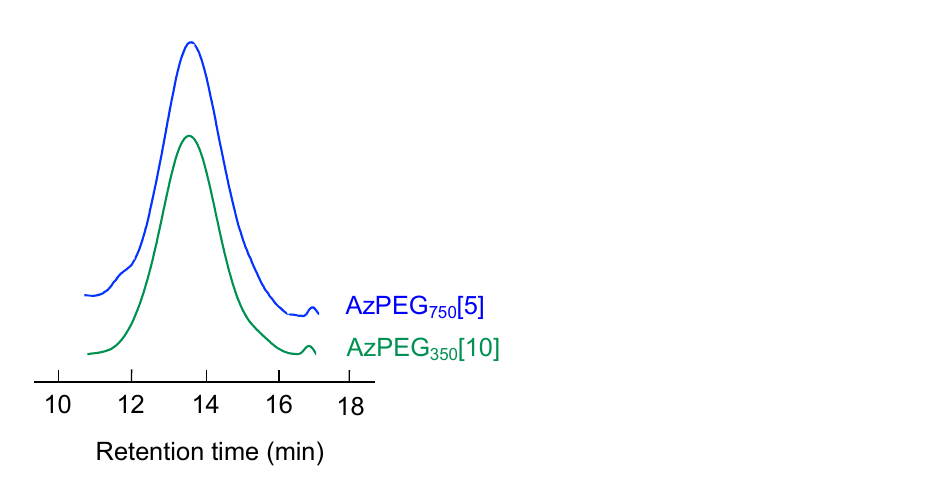
Figure 2. UV absorbance spectra of AzPEG 750 [5] (red) and 4-azidobenzoic acid (blue) in ethanol/wa- ter (0.1 wt.%).